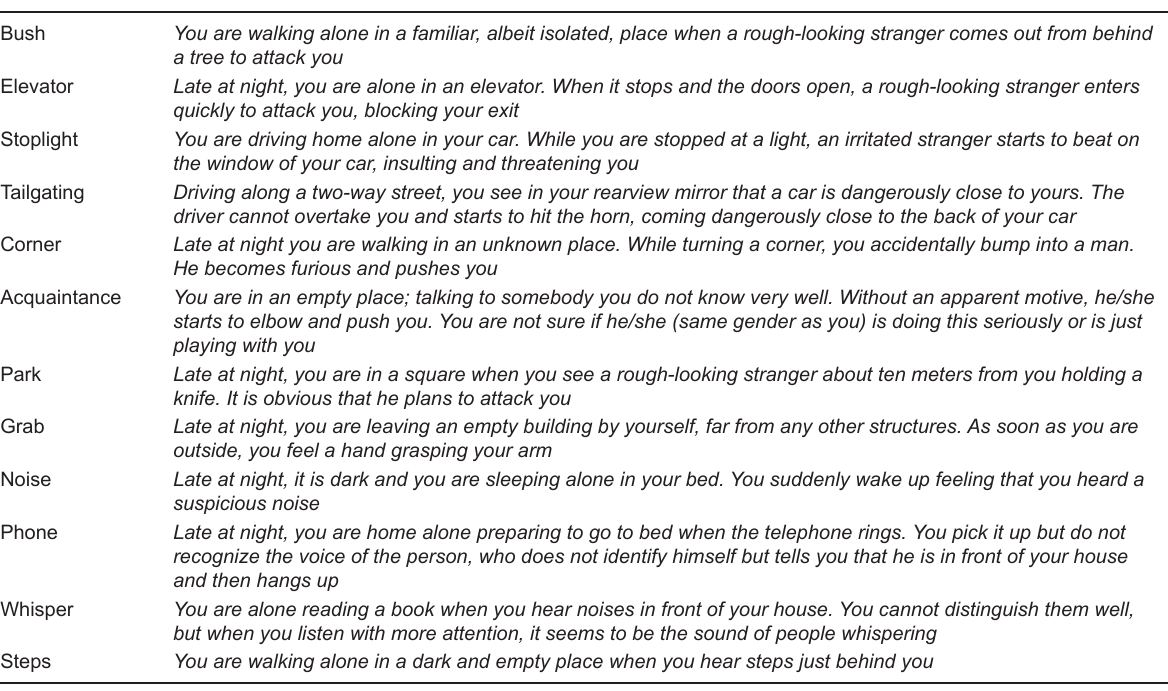
Table 1. Script-scenarios describing conspecific threat situations.